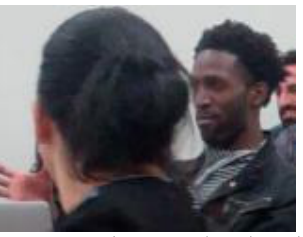
Figure 3 : Onset of line 47: “ YEAH I- ” Figure 4 : Line 49: “that the where -